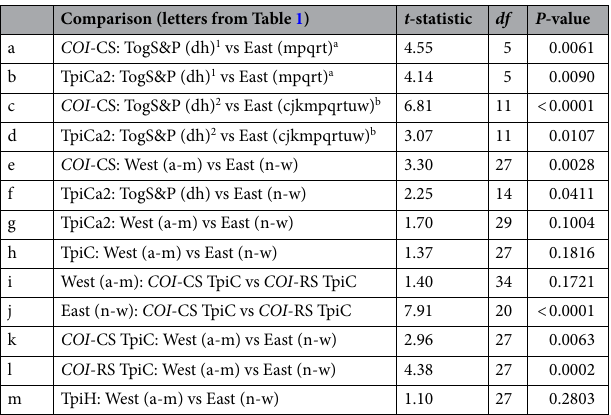
Comparison (letters from Table